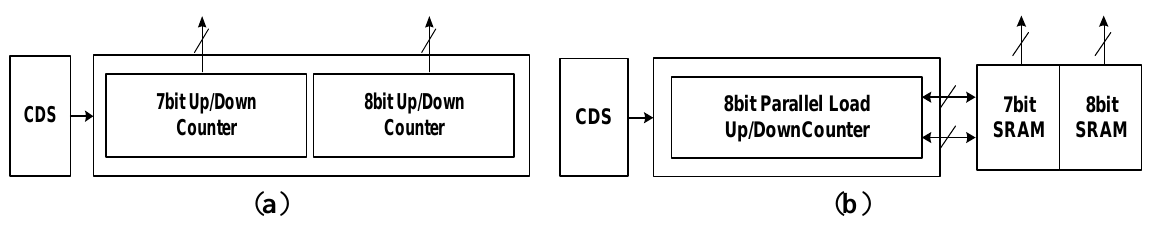
Figure 6. Block diagram of digital CDS: ( a ) conventional digital CDS; ( b ) proposed digital CDS.